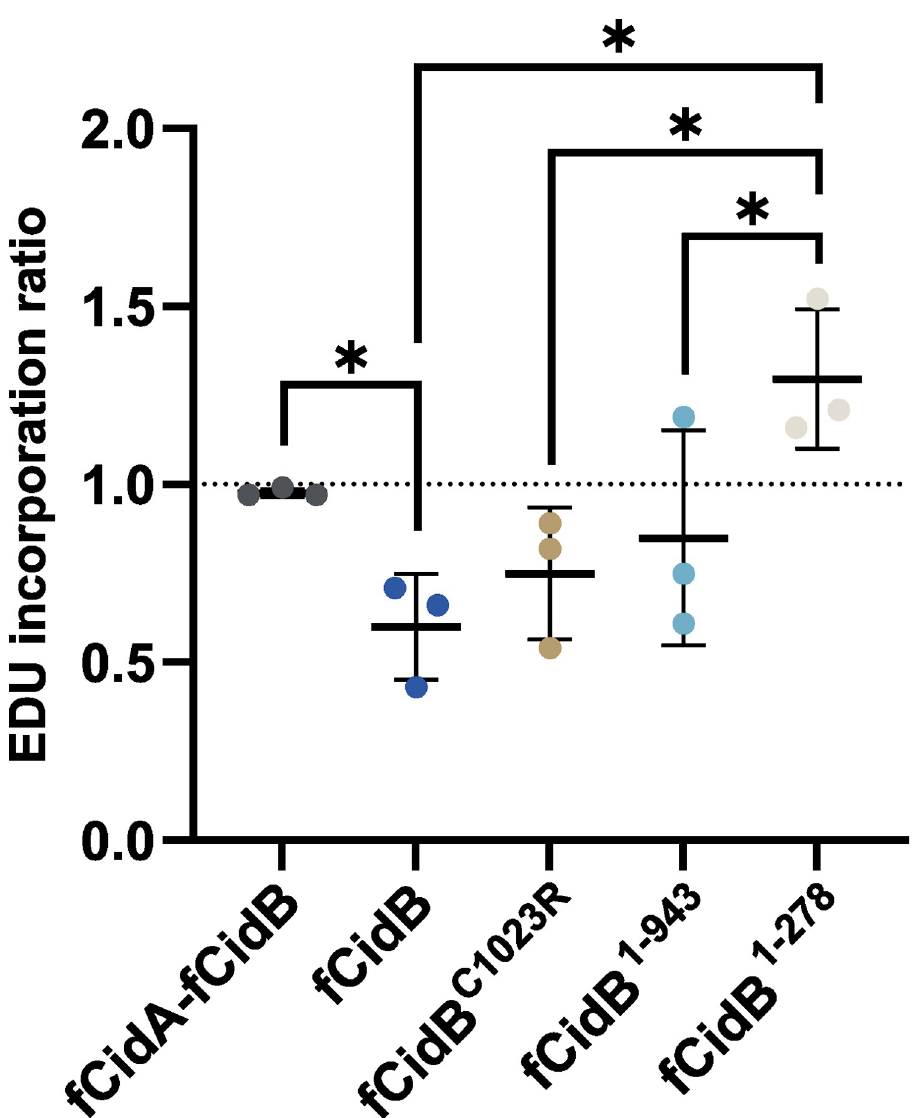
Fig 7. CidB can perturb S-phase progression without a catalytically active DUB domain. FACS analyses of EdU incorporation levels in transfected cells over non-transfected S2R+ cells. The analysis compiles three independent experiments, middle bar is mean, error bars are SD. The � indicates a p < 0.05 with a one-way ANOVA followed by multiple comparisons.